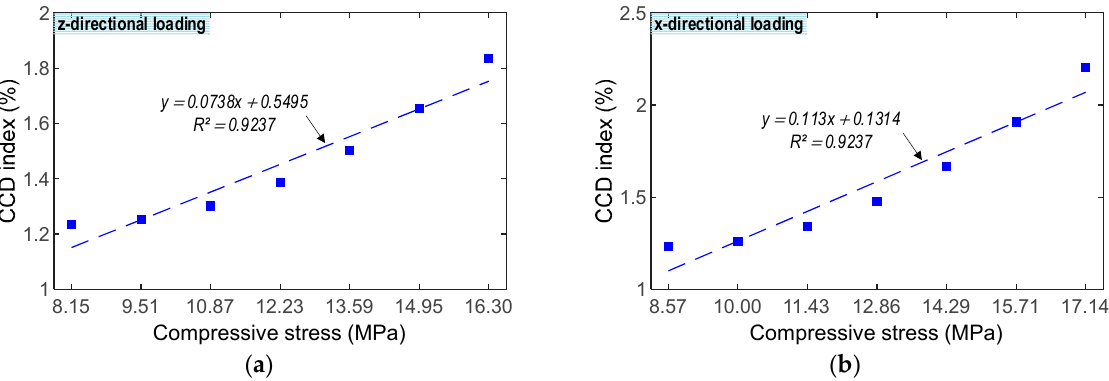
Figure 11. Numerical correlation estimation between CCD index and compressive stress. ( a ) z-directional loading. ( b ) x-directional loading.